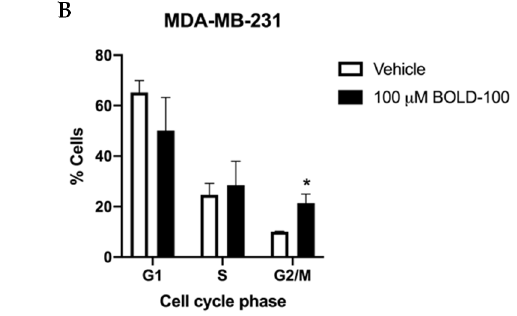
Figure 2. BOLD-100 treatment arrested breast cancer cells in G2/M phase of the cell cycle. Cell cycle analysis of ( A ) MCF7(2) and ( B ) MDA-MB-231 cells with 100 μM of BOLD-100 for 72 h showed significant decrease in S phase and increase in G2/M compared with vehicle treated cells. ANOVA, p < 0.01; * p < 0.05 for respective cell cycle phase in cells treated with 100 μM BOLD-100 compared with cells treated with vehicle.